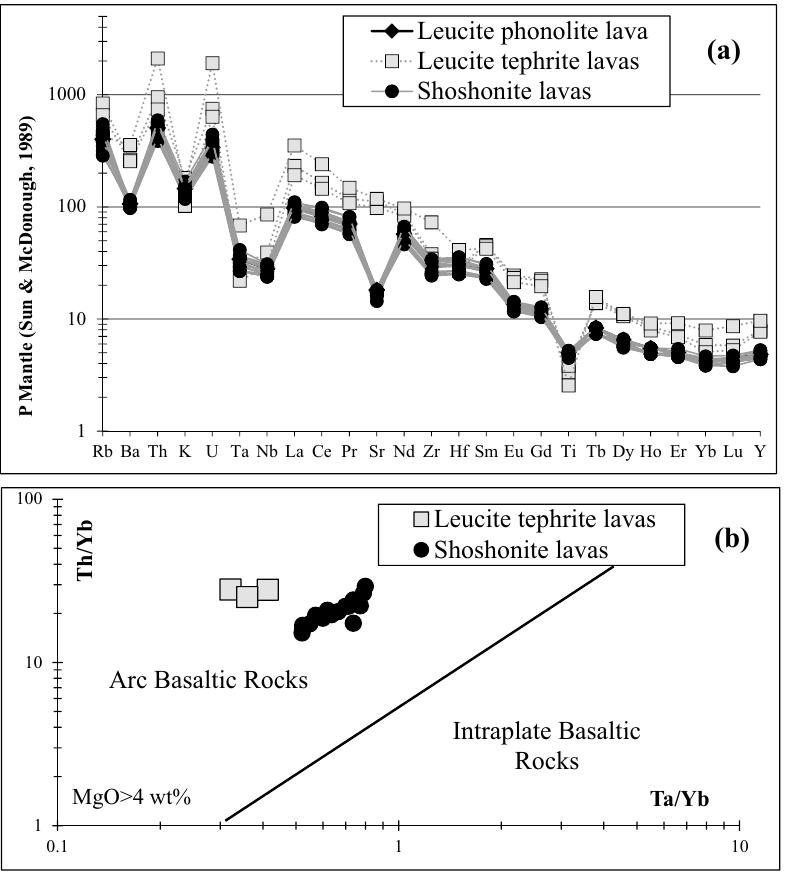
Figure 5. ( a ) Incompatible trace elements patterns normalized to Primitive Mantle 64 ; ( b ) Th/Yb vs Ta/Yb discriminant diagram 67